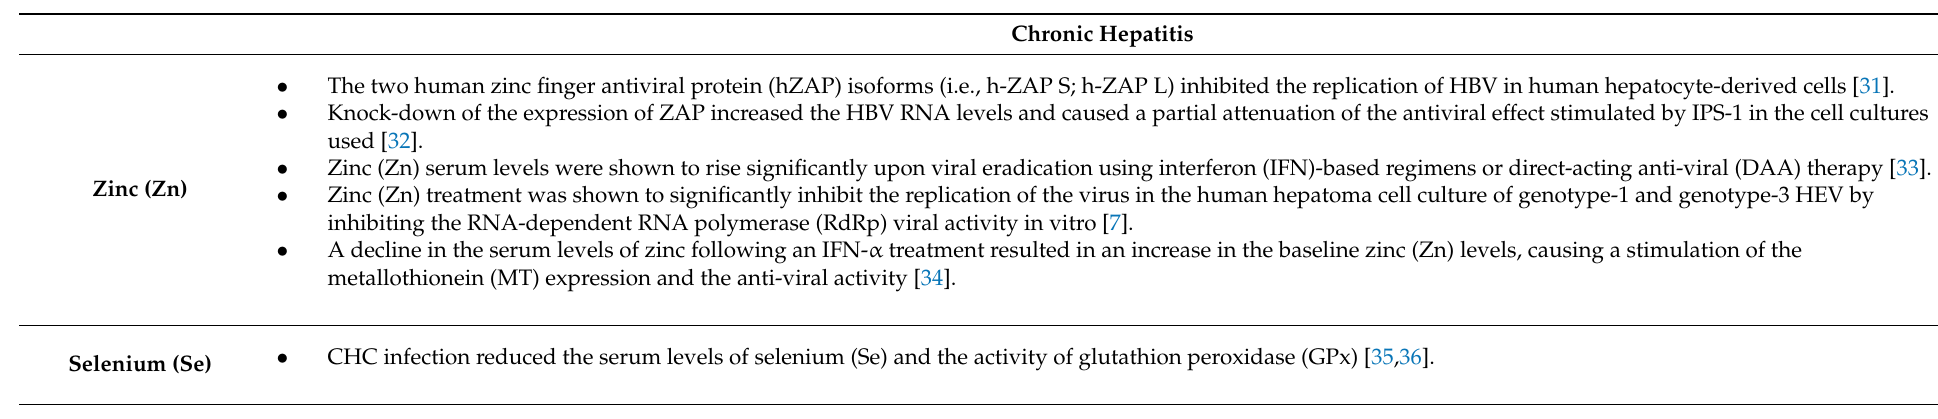
Table 1. Pathogenic pathways and roles of a number of micronutrients in the prevention and/or treatment of chronic hepatitis, COVID-19 and type-2 diabetes